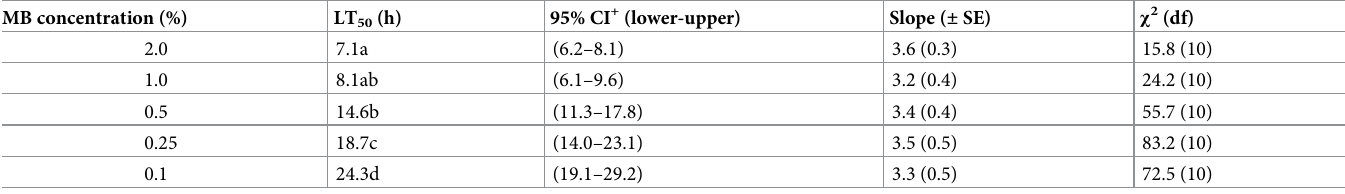
Table 1. Comparing LT 50 of methyl benzoate (MB) against Bemisia tabaci adults after direct spray application of different concentrations (n = 60). MB concentration